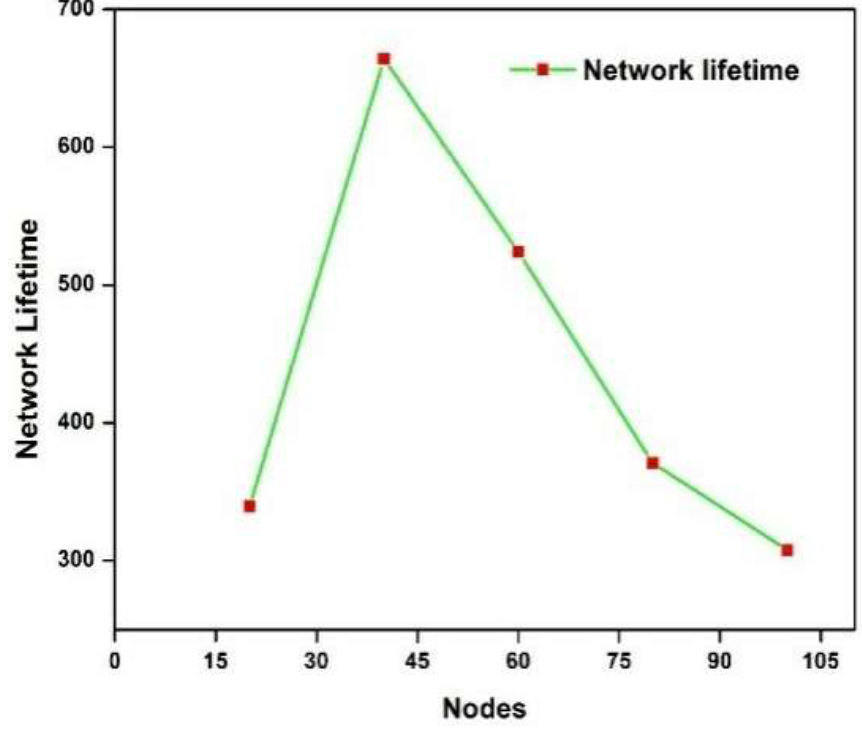
Figure 10. Network lifetime of proposed method. The lifetime of the network of the suggested approach is shown in Figure 10. The lifetime of the network for each node was noted. At node 100, the network lifetime of 307.71 was habited. The increase in nodes was accompanied with an increase in network lifetime. Data Rate-Based Network Lifetime From Table 5, the network lifetime of the proposed method was tabulated at each node with the data set. Nodes with data set values are marked in the Table 5. Table 5. Lifetime of network. Node Date Rate at 4 Date Rate at 6 Date Rate at 8 Date Rate at 10 300 Figure 11 demonstrates the proposed system’s network lifetime. If the data packet rate is low, the network lifetime appears high. From Table 5, we can see that at node 20, the network lifetime of 1339.5 is obtained at a data rate of 4, 896.1 is attained at a data rate of 6, 675.3 is acquired at a data rate of 8, and 500.2 is accomplished at a data rate of 10. At a data rate of 12, 392.2 is gained, and at a data rate of 14, network lifetime is 388. Similarly, in node 40, the network lifetime is 2250 at a data rate of 4, 1575 at a data rate of 6, 1230.1 at a data rate of 8, 963 at a data rate of 10, 650 at a data rate of 12, and 600 at a data rate of 14. More- over, at node 60, network lifetime is 1854.2 at a data rate of 4, 1246.5 at a data rate of 6, 916.3 at a data rate of 8, 669.8 at a data rate of 10, 550 at a data rate of 12, and 500 at a data